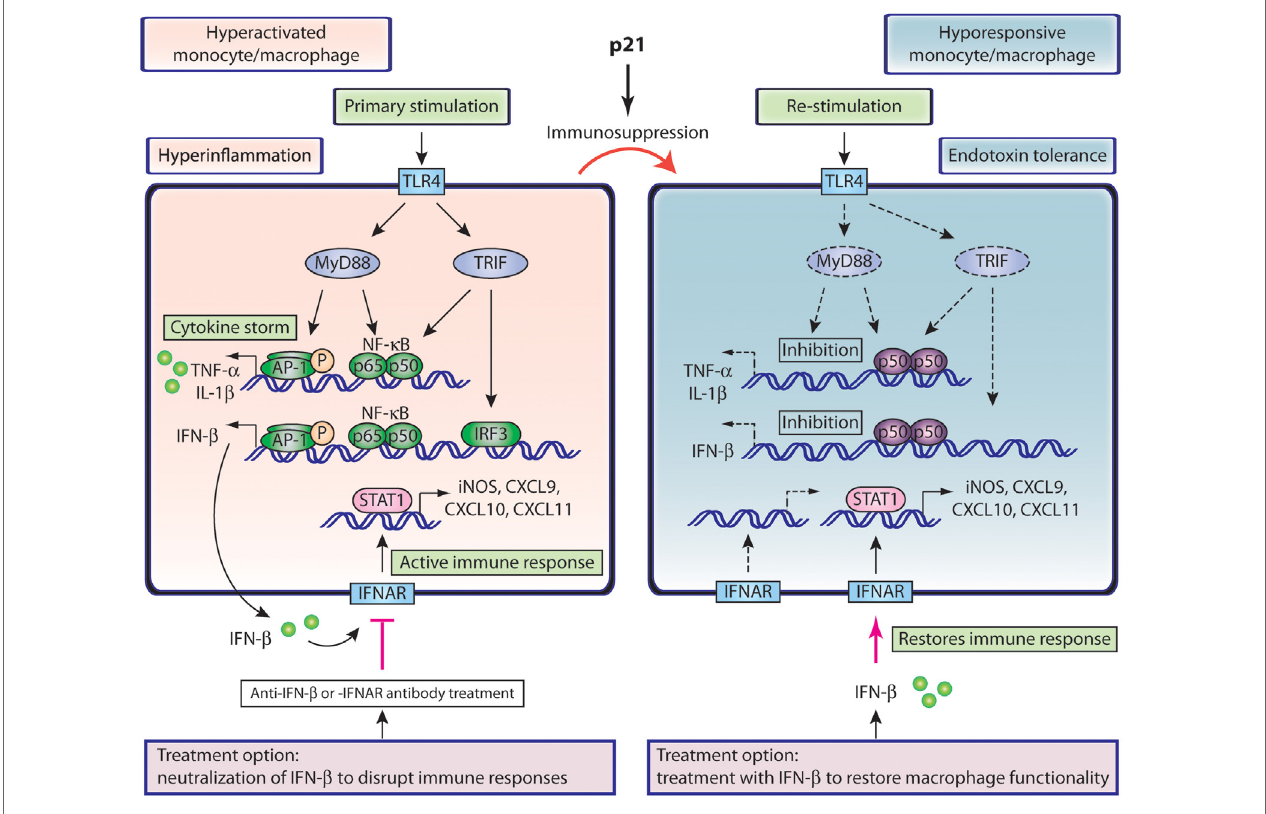
FiGURe 1 | Role of iFn- β in hyperactivated and hyporesponsive monocytes/macrophages . Left, hyperactivated macrophages or monocytes present hyperinflammatory status and elevated IFN- β production. Secreted IFN- β interacts with its receptor and propagates the immune responses through iNOS and chemokine production. Neutralization of the IFN- β pathway interrupts these responses and could be beneficial in sepsis treatment. Right, hyporesponsive macrophages or monocytes associated with delayed sepsis or endotoxin tolerance arise from their hyperactivated counterparts, as a result of immunosuppression, driven by p21. TLR4 restimulation of such cells shows compromised activation pathways and inflammatory cytokine production, including IFN- β . IFN- β treatment could restore compromised monocyte functions and benefit immunosuppressed delayed sepsis